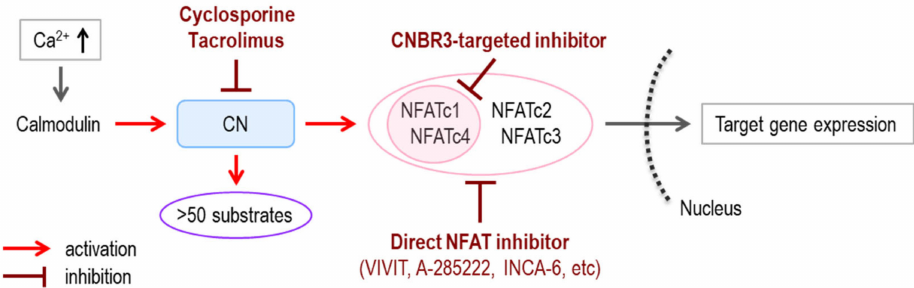
Figure 4. Schematic points of action of selective and non-selective NFAT inhibitors. CN; calcineurin, CNBR3; CN-binding region